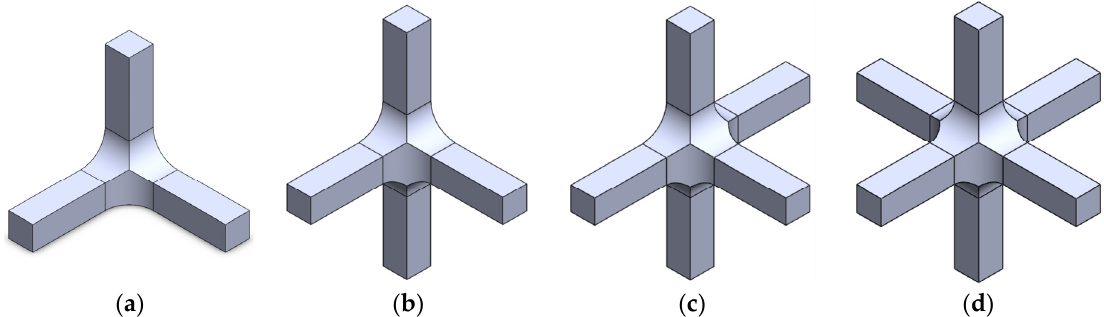
Figure 2. Preliminary design of geometry A: ( a ) CCC loading case; ( b ) CTC loading case; ( c ) CTT loading case; and ( d ) TTT loading case.